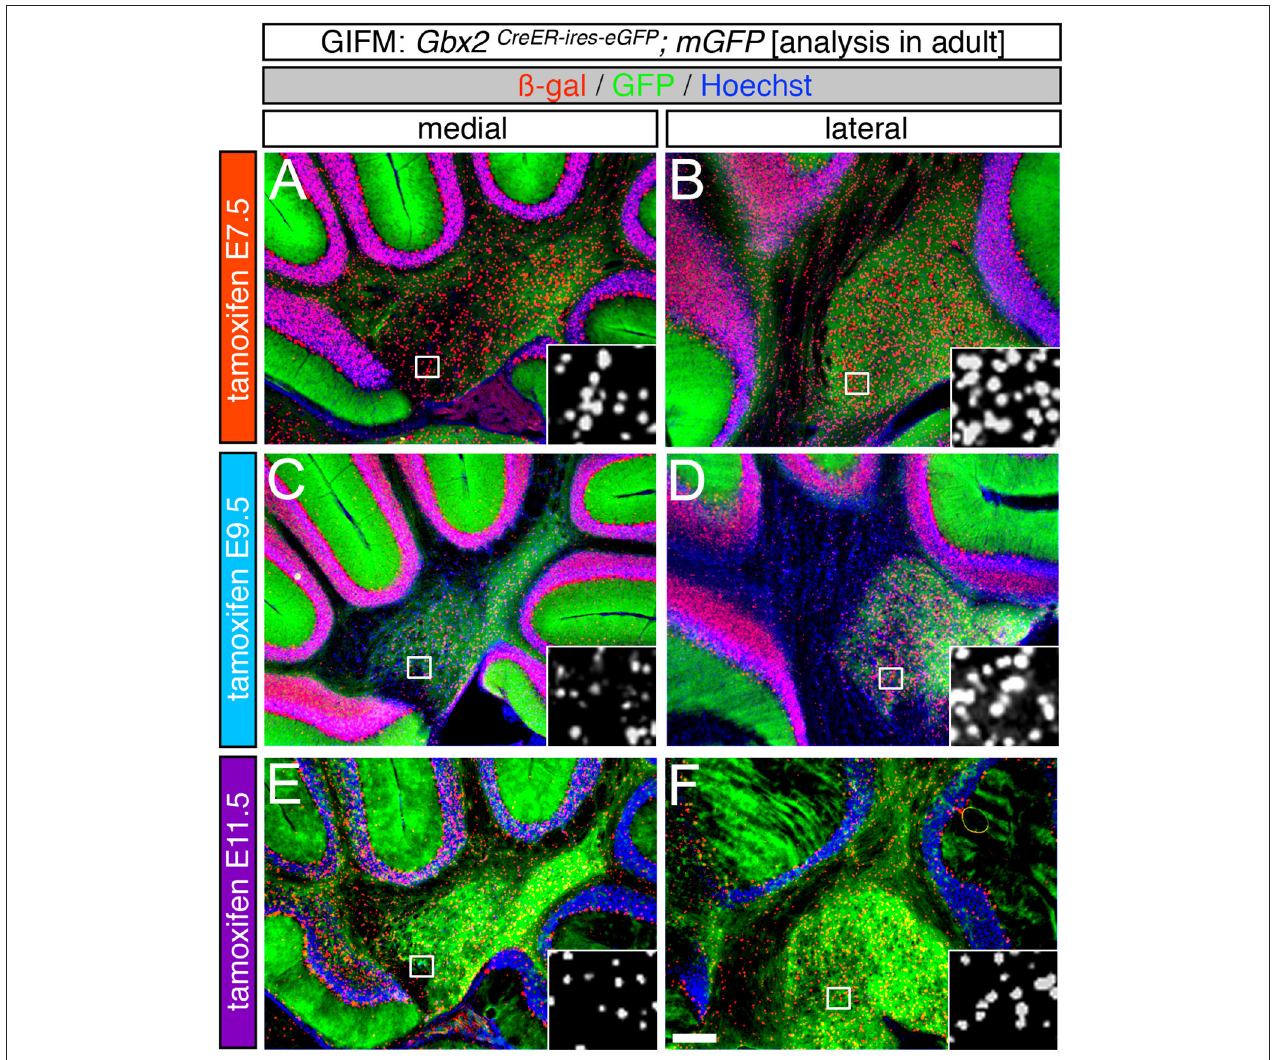
FIGURE 7 | The Gbx2 lineage gives rise to DCN neurons at all five marking stages. ICC on adult sections with antibodies that recognize ß-gal (red) or GFP (green) revealed that Gbx2 expressing precursors contributed to all three DCN. (A–F) Gbx2-derived cells were found in both the medial (A,C,E) and lateral (B,D,F) DCN at every marking stage. Early Gbx2 expressing precursors (E7.5, A,B ) contributed to the DCN more substantially than all subsequent fate mapping stages (C–F) . Scale bar: 180 µ m.